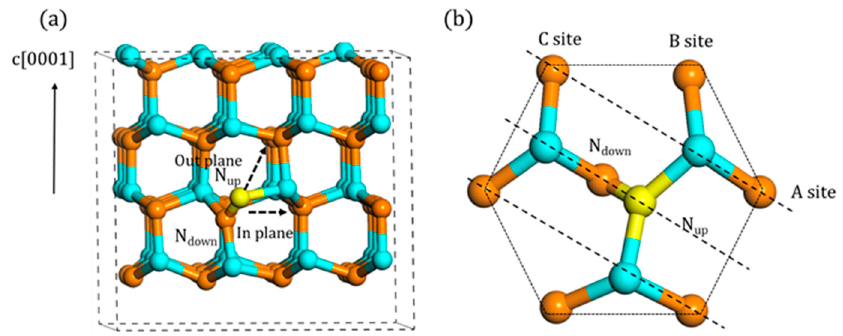
Figure 3. The migration mechanism of A 1 type N i atom (the yellow atom is migrated N atom, the same as below): ( a ) two possible paths and ( b ) the top view of the in-plane migration.